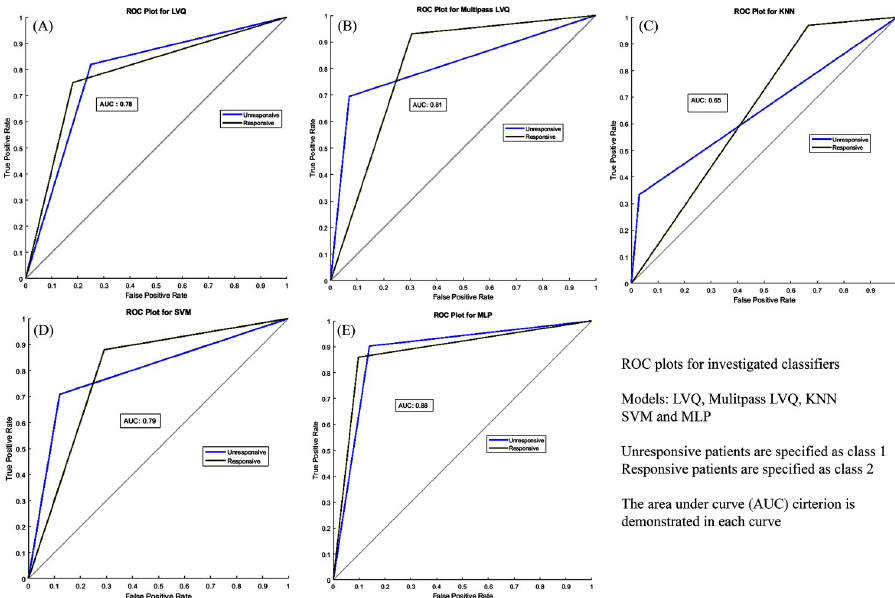
Fig 4. A, Learning vector quantization neural network ROC plot was prepared for unresponsive and responsive classes; B, Multipass learning vector quantization neural network ROC plot was prepared for unresponsive and responsive classes; C, Multilayer perceptron neural network ROC plot of unresponsive and responsive classes; D, Support vector machine ROC plot of unresponsive and responsive classes; E, K-nearest neighbors ROC plot of unresponsive and responsive classes.